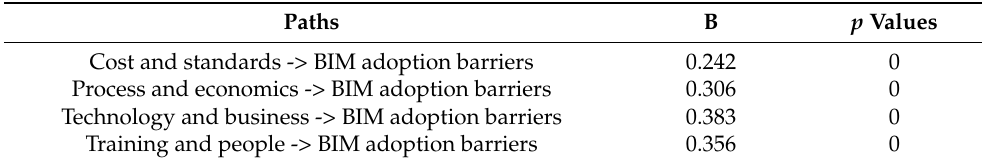
Table 4. Formative construct analysis.